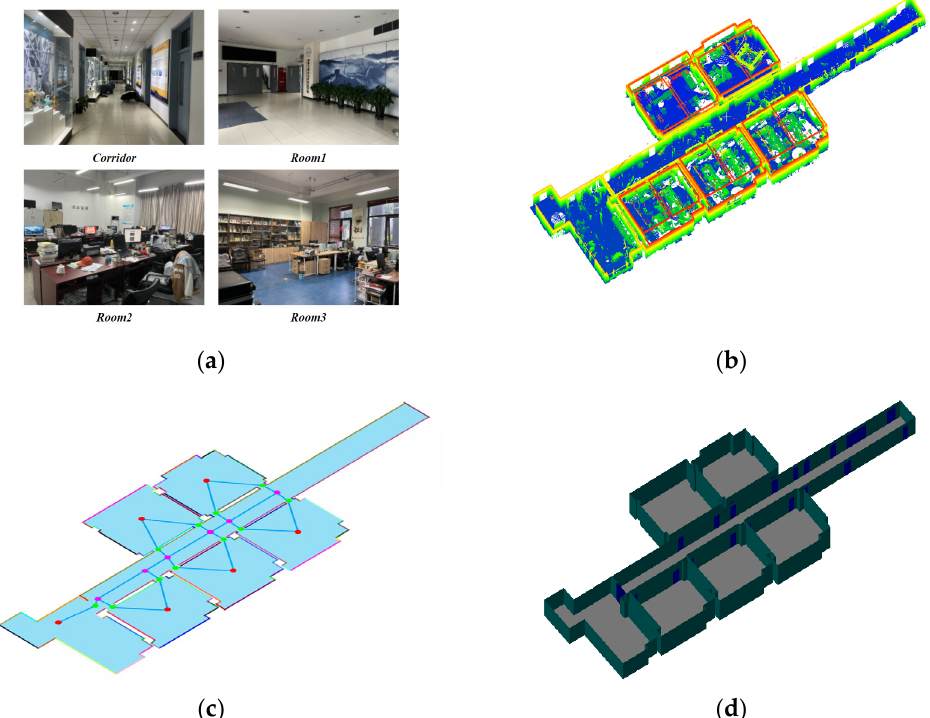
Figure 18. Practical work examples. ( a ) is a real scene. ( b ) is the real point cloud. ( c ) is the navigation network. ( d ) is the 3D semantic model.